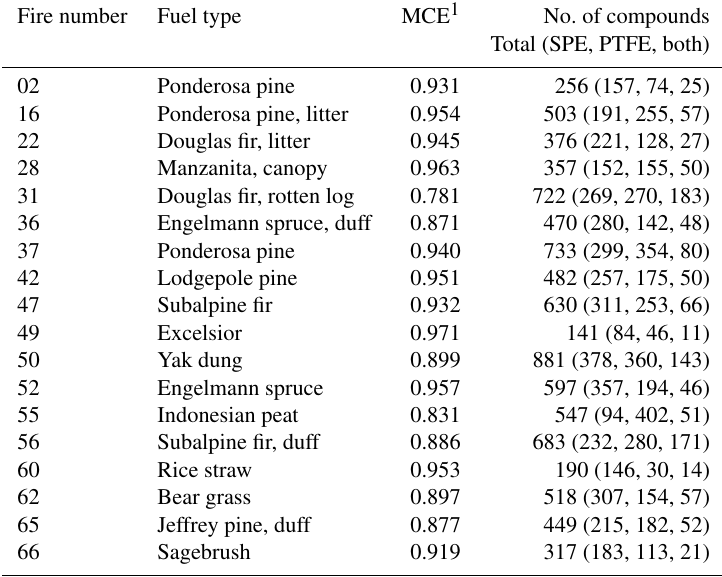
Table 1. Summary of sampled